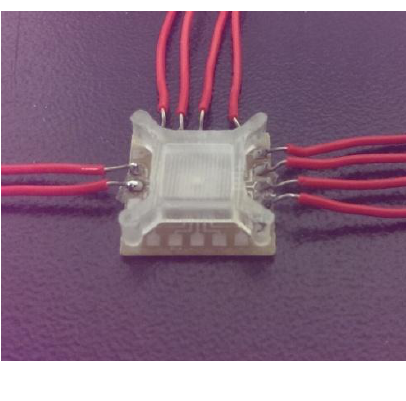
Figure 9. Optical image of the magnetic sensor after completion of